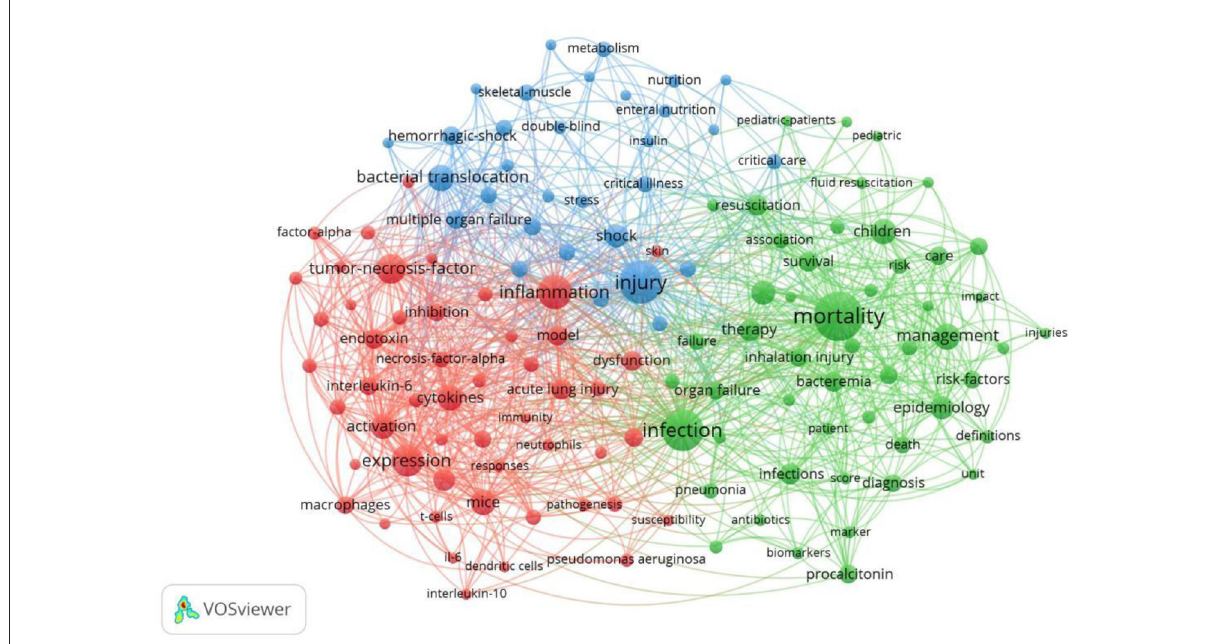
FIGURE6 Bibliographic analysis of all keywords in co-occurrence references network map. Based on the relevance of keywords, it can be divided into three different color clusters: cluster one is red, cluster two is green, and cluster three is blue. The size of circles indicates the frequency of occurrence. The larger the nodes, the more frequently the keyword appeared.